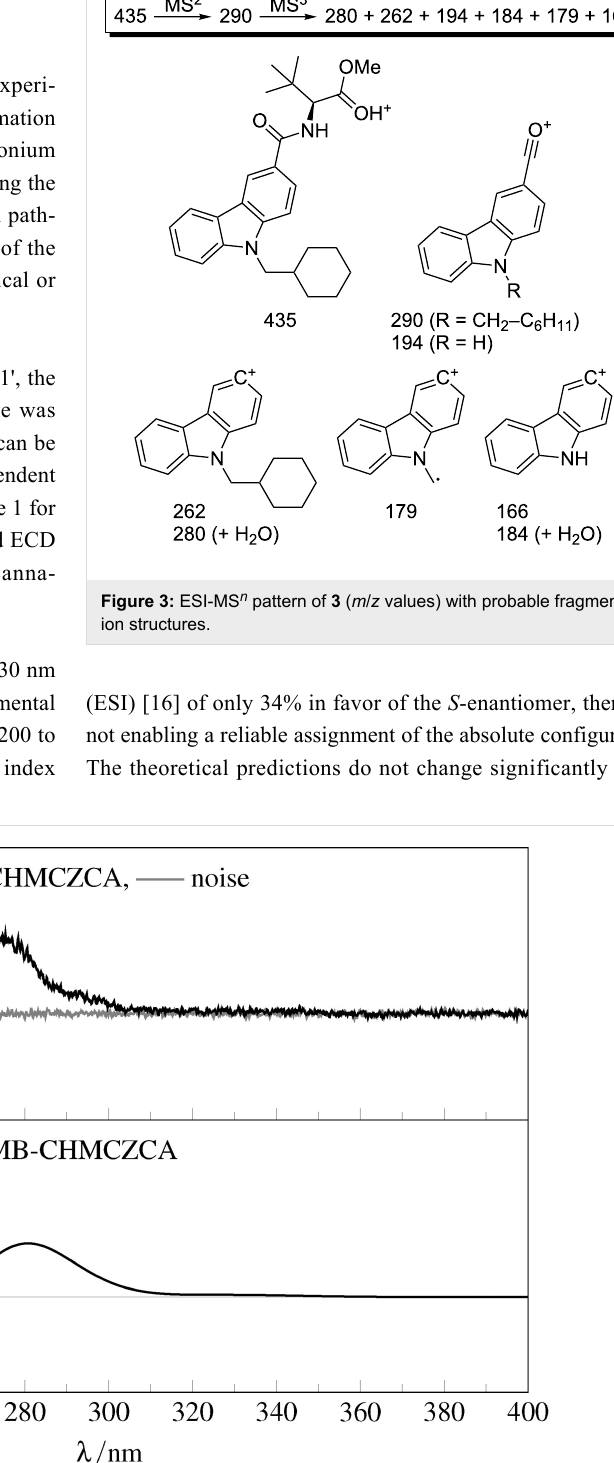
Figure 4: Observed (top) and calculated (bottom) ECD spectra for ( S )- 3 in acetonitrile, theory level: TD-B3LYP/6-311++G**/IEFPCM//B3PW91/6- 311G**/IEFPCM.